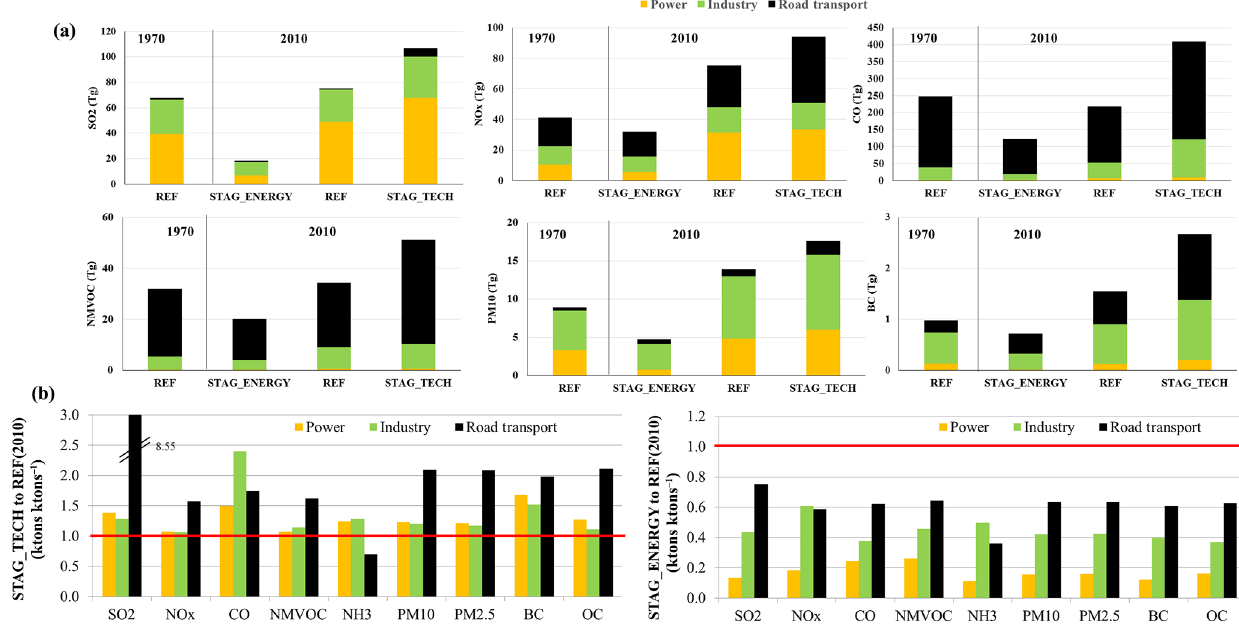
Figure 3. (a) Overview of 1970 (only for REF) and 2010 emissions for REF, STAG_TECH and STAG_ENERGY at the global scale for the power generation, industry and road transport sectors. (b) The ratios in 2010 of STAG_ENERGY to REF(2010) and STAG_TECH to REF(2010) are presented. The red line indicates no change relative to the reference emissions in